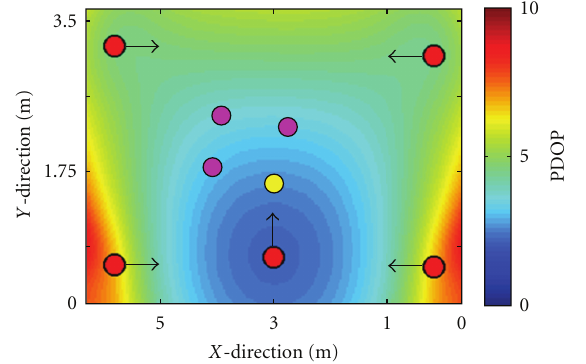
Figure 14: Wave propagation (ray tracer) model of the laboratory room, where the measurements were performed. The green points represent the APs, and the yellow one shows the position of the MU during